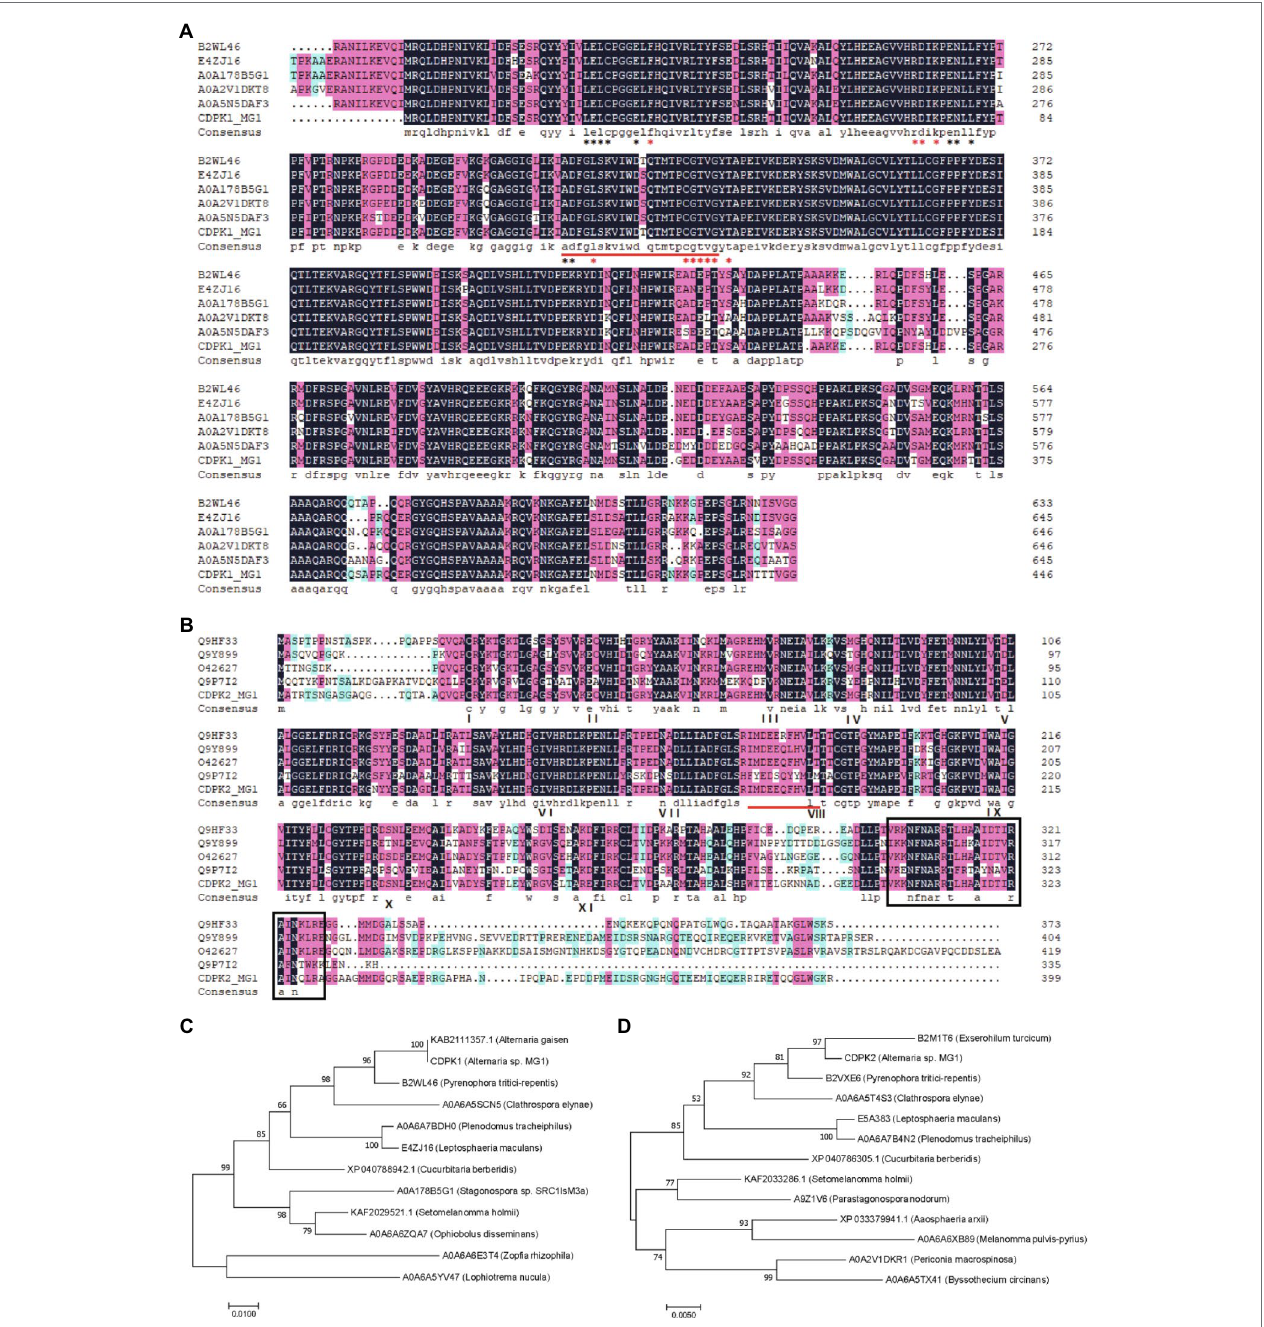
FIGURE 6 | Sequence analyses of CDPK proteins. Multiple sequence alignment of CDPK1 (A) and CDPK2 (B) with other calmodulin-dependent proteins. The putative activation loop motifs are indicated by red underline. The ATP binding site and polypeptide substrate binding site are marked with black and red asterisks, respectively. The numbers I-XI below the CDPK2 sequence indicate conserved protein kinase catalytic subdomains. The calmodulin-binding domain is highlighted with black border. Identical amino acids are shown with dark blue backgrounds, highly similar (50–99%) amino acids are shown with pink backgrounds, and amino acids with low similarity (33–50%) are shown with light blue backgrounds. Phylogenetic analysis of CDPK1 (C) and CDPK2 (D) with other CDPK sequences as a neighbor-joining